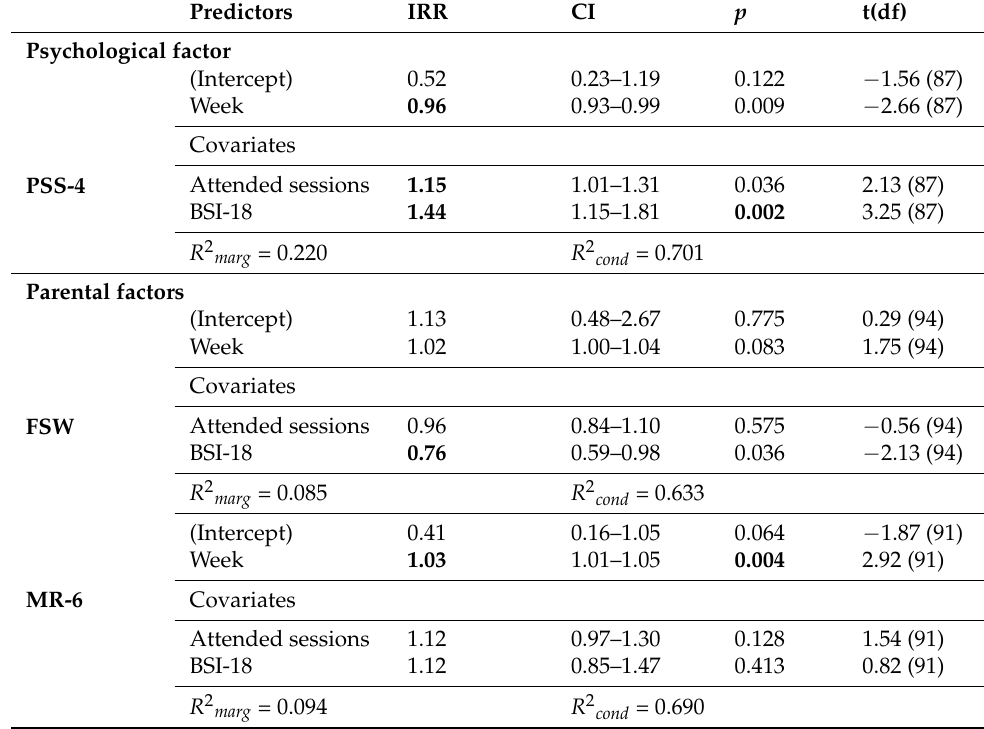
Table 2. Conditional growth